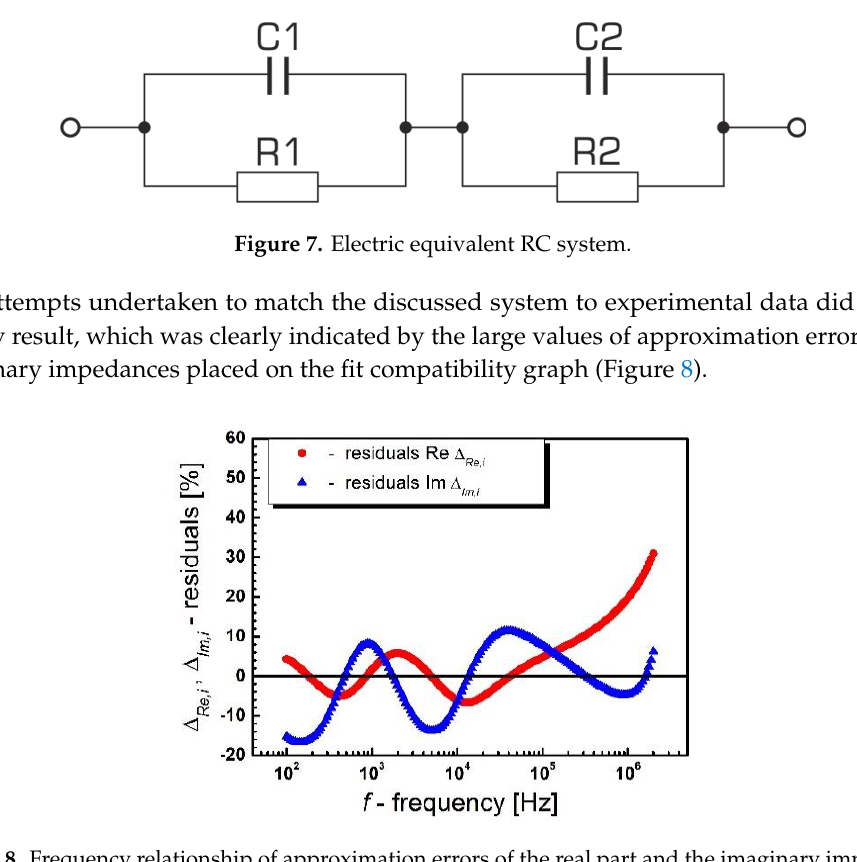
Figure 8. Frequency relationship of approximation errors of the real part and the imaginary impedance of BLT 4 ceramics, calculated at T = 377 °C.